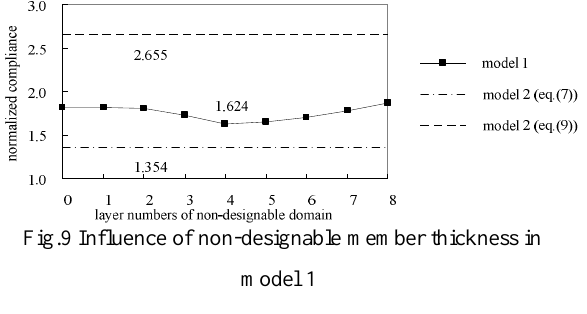
Fig.9 Influence of non-designable member thickness in